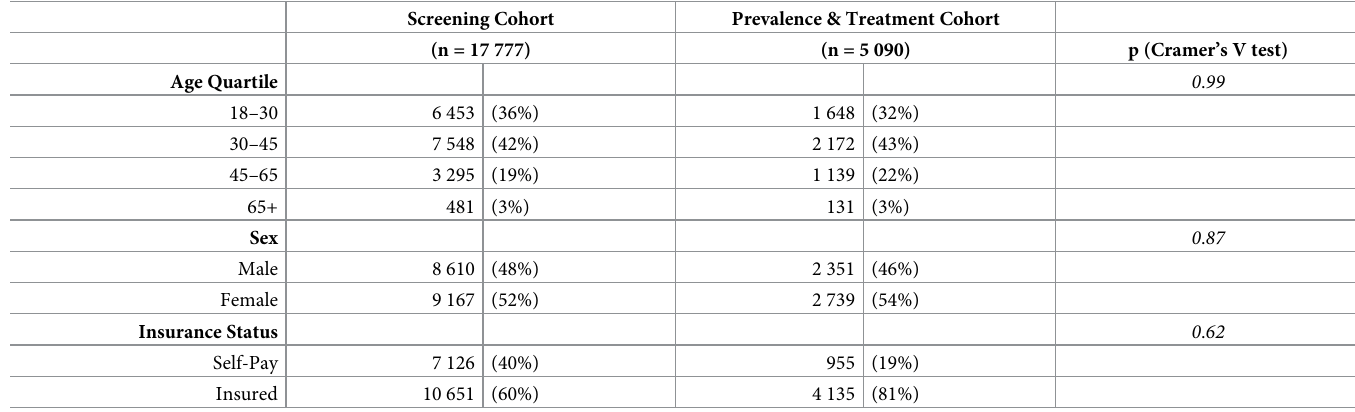
Table 1. Baseline characteristics of study population and